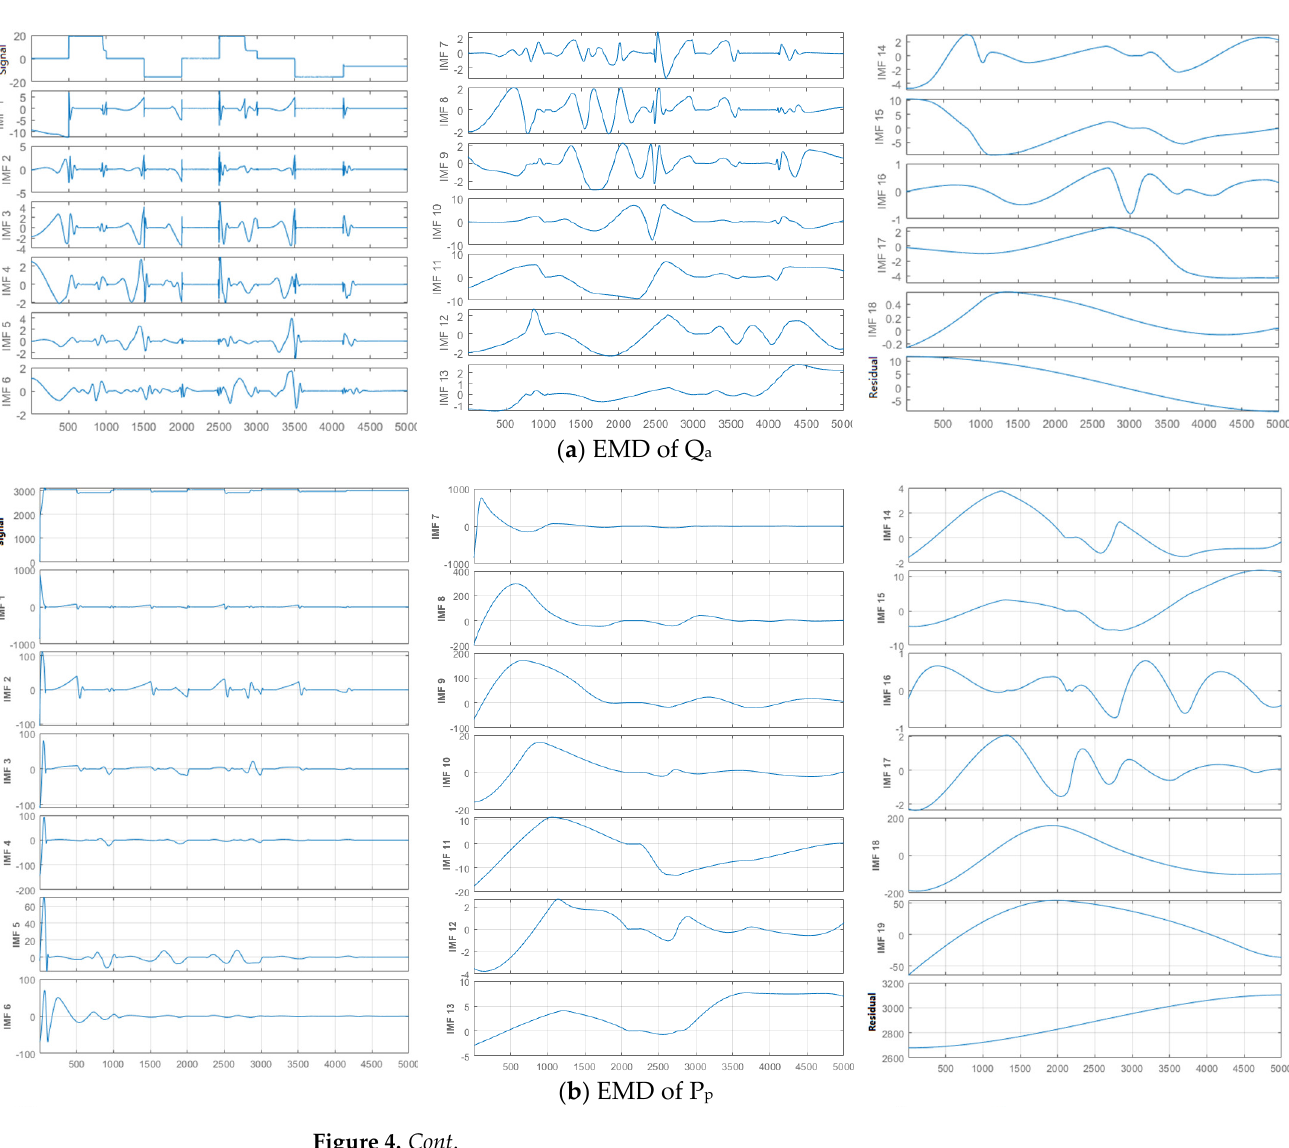
( c ) EMD of D a Figure 4. EMD results of different channel signals. The oil filter blockage (FB) state is simulated. The EMD of Q a obtains 18 IMFs, the EMD of P p obtains 19 IMFs, and the EMD of D a obtains 12 IMFs. From Figure 4, different IMFs can reflect the characteristics of the original signal to a certain extent. Each original signal can obtain a set of feature vectors after the EMD, and the EMD results can be marked as F n = [IMF 1 , IMF 2 , ... IMF K , r], with k meaning the total number of IMFs after the EMD, and r meaning the residual after the EMD. From the three sets of EMD signals in the figures, the types of information containing and expressing are different, so the total number of IMFs are not consistent. The IMFs after the EMD enriches the input features of the LSTM networks. However, it is inevitable that there are redundancy or repetition of information, and the input dimensions of the LSTM are not the same. Therefore, the PCA method needs to be applied to reduce the dimension of the input IMFs. Principal component analysis (PCA) is a statistical method for the main component of a signal, and converts a set of variables that may exist into a set of linear irrelevant variables through orthogonal transformation. This set of variables is called the main in- gredient. The PCA method was proposed by Karl Pearson [33]. Presently, it has been widely used in many fields, such as mode recognition, signal processing, signal compres- sion, and fault diagnosis [34–36]. The PCA method can ensure that the main characteristics of a signal are not lacking and realize the simplification of data; this can greatly reduce